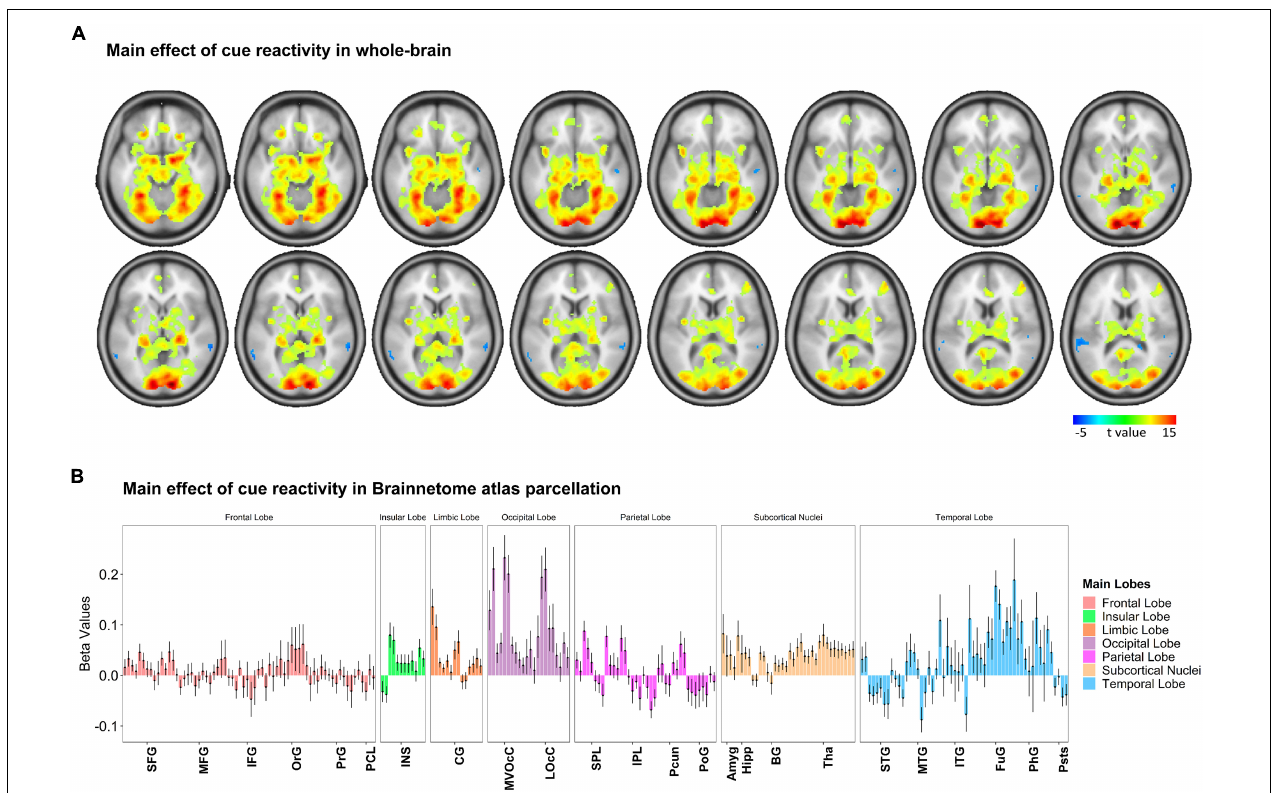
FIGURE 3 | Whole-brain response to the task-based fMRI in contrasts of Food > Neutral. (A) Brain activation maps and (B) changes in brain activation in Brainnetome (BNA) regions. Based on the whole-brain analysis, changes in brain activation (contrast: food > neutral) in terms of beta values obtained from the general linear modeling (GLM) are represented to examine how food cue-reactivity influenced the brain’s circuitry. The details of brain activation changes for each subregion of the Brainnetome Atlas are shown in Supplementary Figure 2 , and the ontology and nomenclature of brain areas and their abbreviations in the Brainnetome Atlas and associated Brodmann areas are listed in Supplementary Table 1 . Data in bar charts are represented as mean ± SEM. SFG, superior frontal gyrus; MFG, middle frontal gyrus; IFG, inferior frontal gyrus; OrG, orbital gyrus; PrG, precentral gyrus; PCL, paracentral lobule; STG, superior temporal gyrus; MTG, middle temporal gyrus; ITG, inferior temporal gyrus; FuG, fusiform gyrus; PhG, parahippocampal gyrus; pSTS, posterior superior temporal sulcus; SPL, superior parietal lobule; IPL, inferior parietal lobule; Pcun, precuneus; PoG, postcentral gyrus; INS, insular gyrus; CG, cingulate gyrus; MVOcC, medioventral occipital